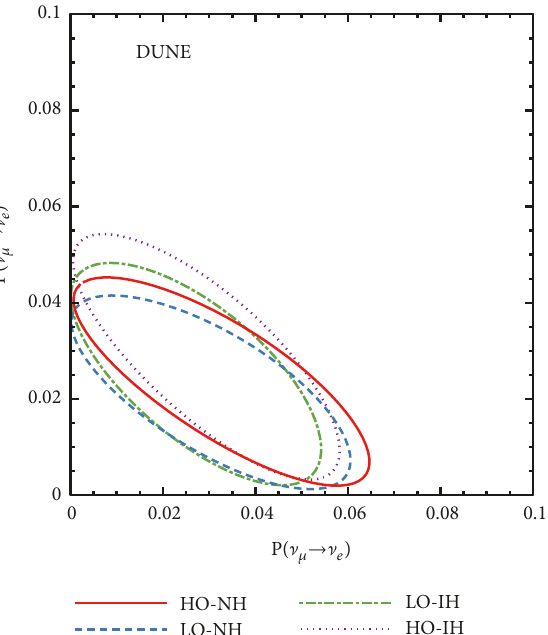
Figure 1: The biprobability plots with 𝜖 푒휇 = 0.04 and 𝐶𝑃 -phase 𝛿 푒휇 = 𝜋/2 for DUNE with baseline 𝐿 = 1300 km and 𝐸 = 3 GeV. The standard 𝐶𝑃 -phase 𝛿 is varied from 0 to 2𝜋